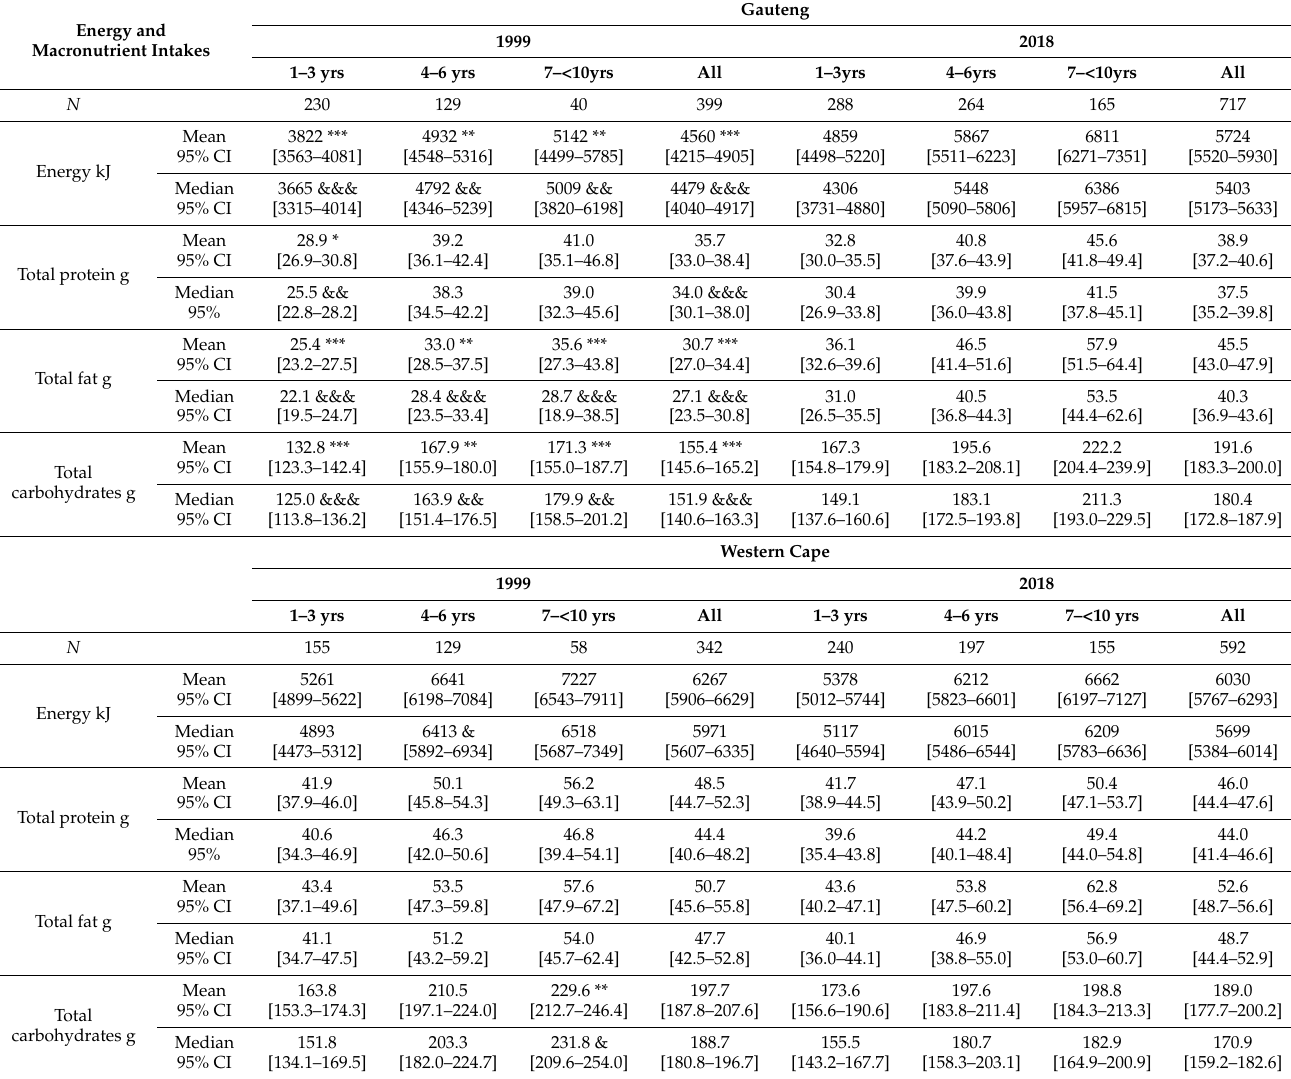
Table 5. Comparison of mean [95% CI] and median [95% CI] macronutrient intakes of children 1–<10-years-old between 1999 and 2018. for Gauteng and Western Cape, by age group and